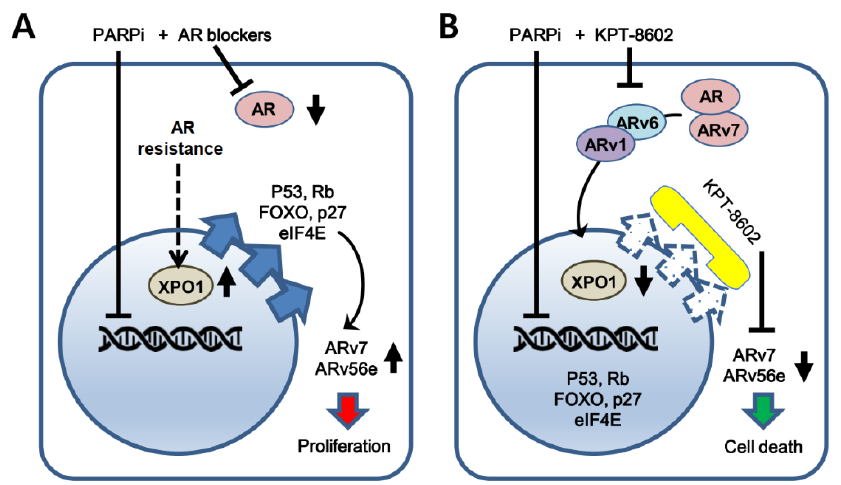
Figure 6. Schematic diagram illustrating the working hypothesis for the sensitization of mCRPC cells to XPO1 and PARP inhibitors. ( A ) Mechanism of drug resistance with traditional PARP inhibitor and AR-targeted agent treatment. ( B ) Sensitization of mCRPC cells using second generation SINE compound KPT-8602 and PARP inhibitors. BRCA1/2 deficient mCRPC growth cannot be sufficiently blocked by PARP inhibitors and AR blockers since the tumor suppressor proteins (TSPs) are functionally inactivated due to their excessive export to the cytoplasm. KPT-8602 can retain TSPs such as TP53, RB, FOXO, P27 and AR translation promoter eIF4e in the nucleus to facilitate the induction of cell death signals. Moreover, by keeping AR and ARv7 in the nucleus, KPT-8602 interrupts AR- and ARv7-mediated import of ARv1 and ARv6 in the nucleus.